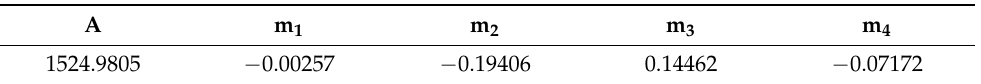
Table 2. Material constants of the 55NiCrMoV7 steel in the Hansel–Spittel model (parameter values were obtained from the approximation of Equation